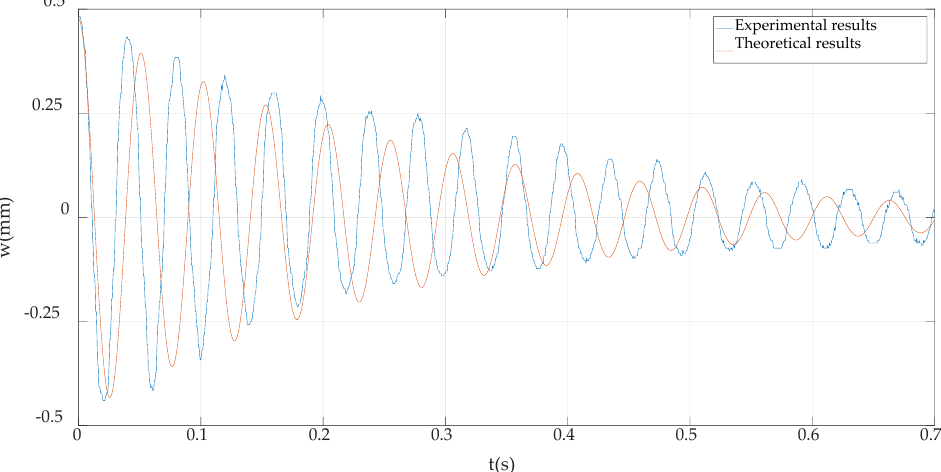
Figure 4. The time–displacement curves under the initial displacement of 0.475 mm.